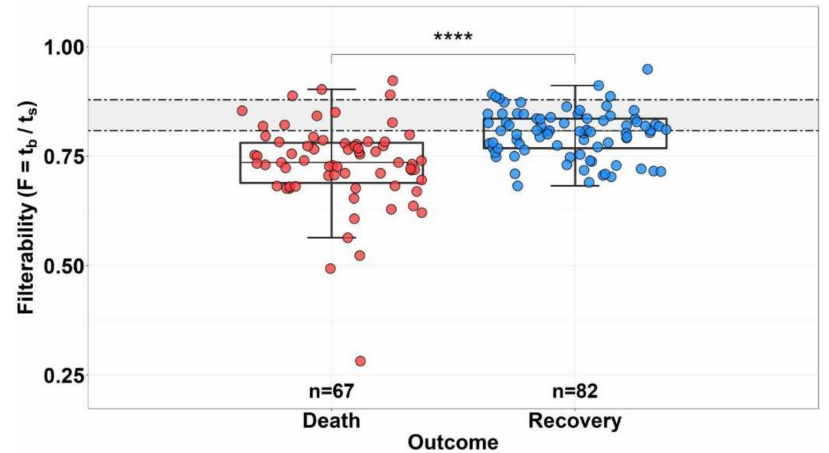
Figure 3. Distribution of RBC filterability in the group of deceased (n = 67) and survivor (n = 82) patients with COVID-19. Horizontal dotted lines indicate the boundaries of normal filterability values. **** The difference between the groups is significant ( p < 0.0001).